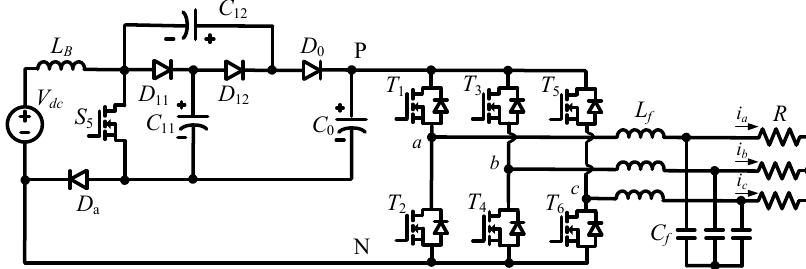
Figure 7. Proposed three-phase VMC-qSBI in simulation.